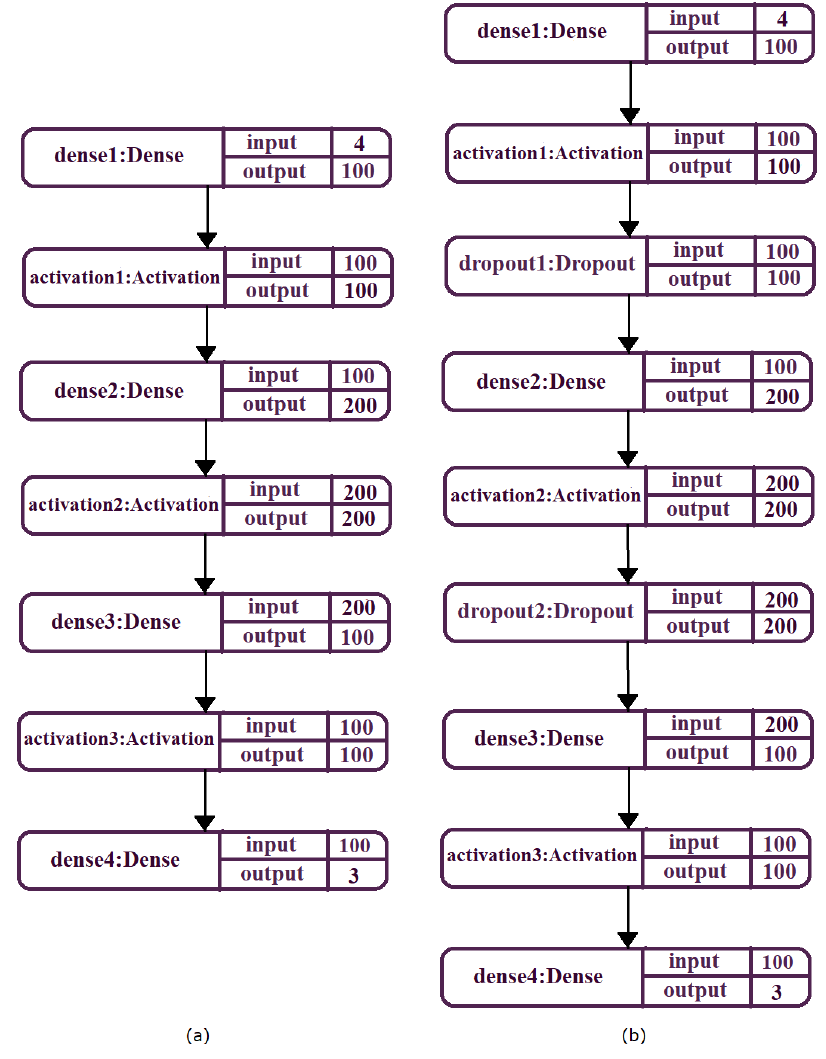
Figure 13. LSTM architecture. Figure 13. ( a ) LSTM architecture. ( b ) The modified MLP architecture.